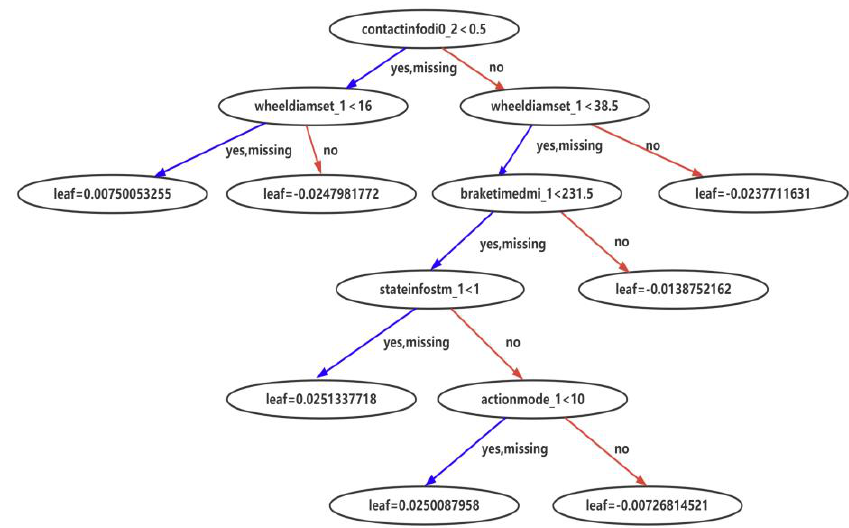
Figure 13. Typical sub-model (tree) of the ensemble by the training with 2018-T(C).